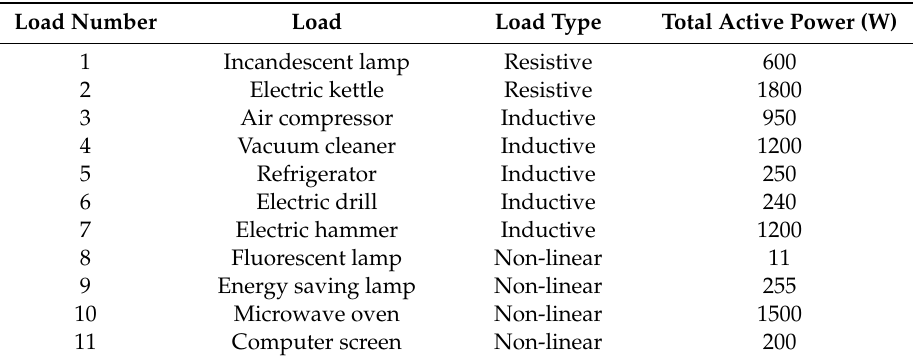
Figure 20. Physical diagram of experimental loads. Table 6. Parameters of different types of loads.